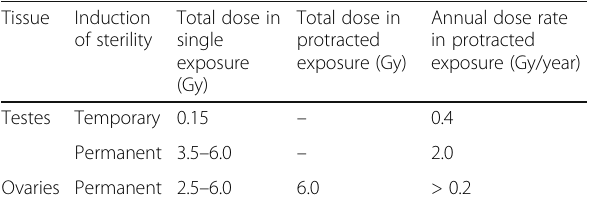
Table 1 Estimates of the threshold absorbed dose for tissue effects in adult human gonads [35] Tissue Induction Total dose in of sterility